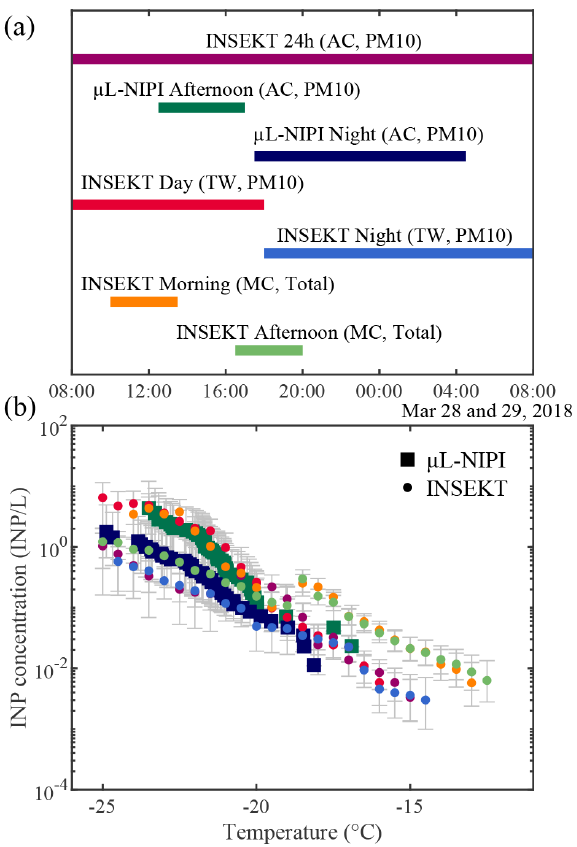
Figure 9. (a) Timeline of the filter sampling carried out on 28 March 2018. The droplet-freezing assays used for the INP anal- ysis (INSEKT; µL-NIPI), the sampling locations (MC = main cot- tage; AC = aerosol cottage; TW = tower) and the inlets used during sampling (Total, PM 10 ) are indicated. The colored bars indicate the various sampling time windows and correspond to the colors used in the INP temperature spectra presented in the bottom panel and in Fig. 11. (b) INP temperature spectra measured for each filter col- lected on 28 March 2018. For the INSEKT data, the error bars rep- resent the statistical as well as the systematic error of the INSEKT assay. More details related to the calculation of these error bars is given in Schneider et al. (2021). For the µL-NIPI data, the error bars were calculated using the Poisson Monte Carlo procedure as described in Harrison et al. (2016).